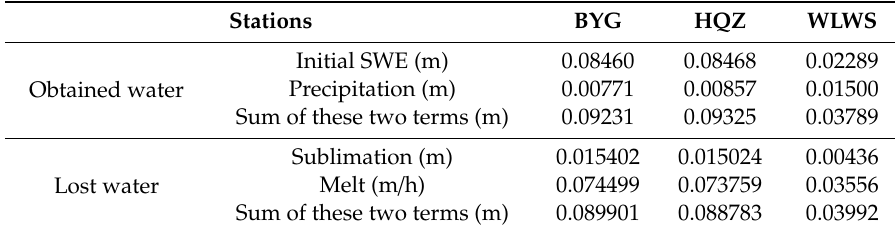
Figure 9. Trends in the simulated snowmelt outflow and related energy items at 3-hour intervals between 0:00 on 1 November 2014 and 21:00 on 31 March 2015. Table 7. Comparison between the simulated water loss and measured water loss in March 2015. Stations